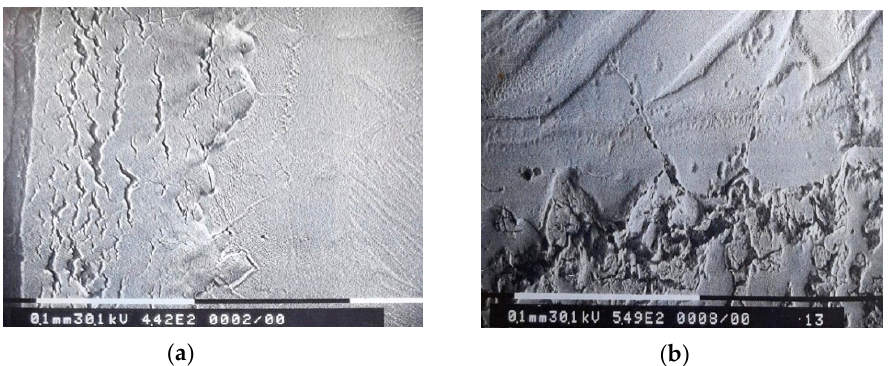
Figure 3. MEB microstructure of corrosion layers. Degradation processes in the oxide layers and at the oxide–metal interface at ( a ) 1000 °C, ( b ) 1050 °C.